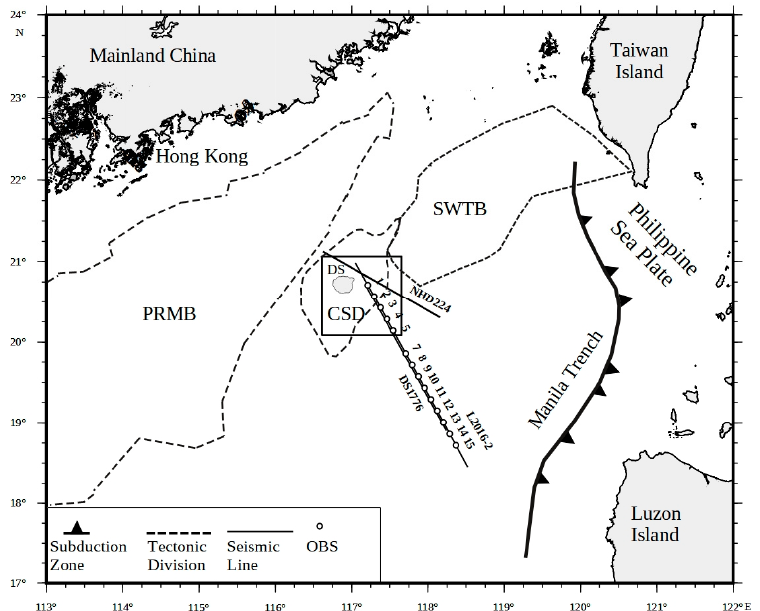
Figure 1. Locations of the Dongsha Island (DS), tectonic division [9], and seismic lines in the northeastern South China Sea. PRMB = Pearl River Mouth Basin; CSD = Chaoshan Depression; SWTB = Southwest Taiwan Basin; the box is the study area (also shown in Figure 2), and the black circle denotes the OBS station.